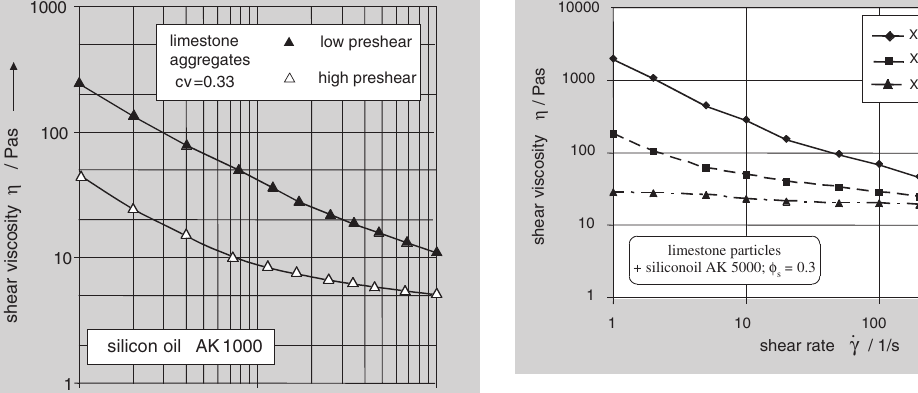
Figure 2a (left): Shear viscosity functions of silicon oil-limestone aggregate suspensions before and after intensive deaggregation shear treatment at 25°C. Figure 2b: Shear viscosity functions of silicon oil-limestone non-aggregated particle suspensions of various mean particle size (x 50,3 ) at 25°C